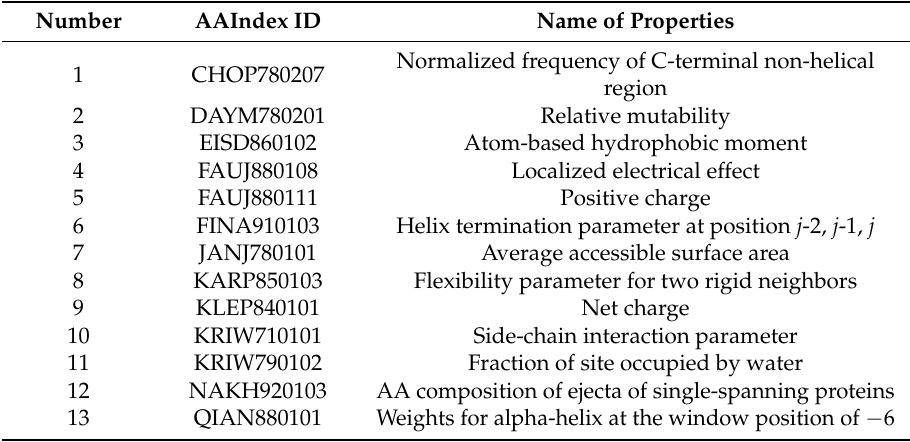
Table 10. Selected properties from the AAIndex database. AA—amino acid.